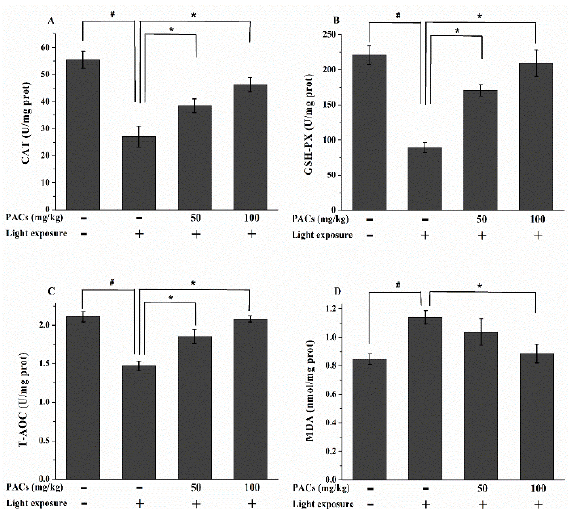
Figure 3. Changes in ( A ) CAT and ( B ) GSH-Px activities, as well as ( C ) total antioxidant capacity